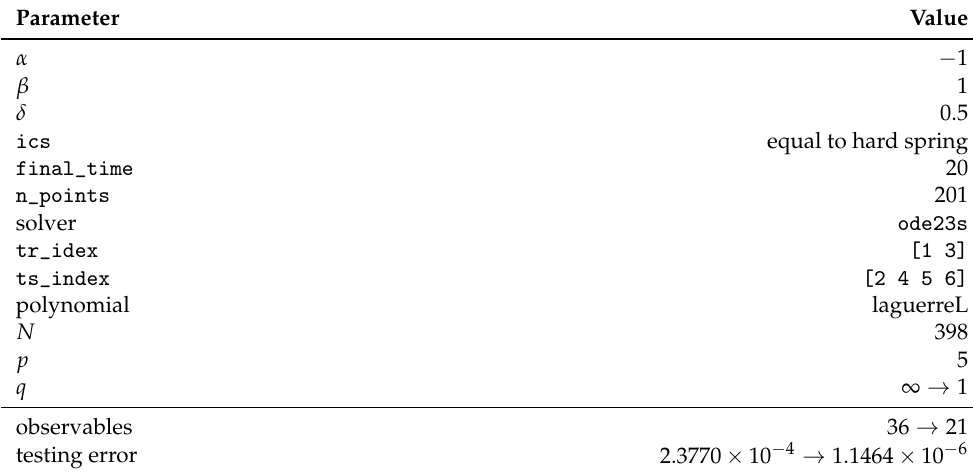
Table 2. Approximation parameters for the soft spring Duffing